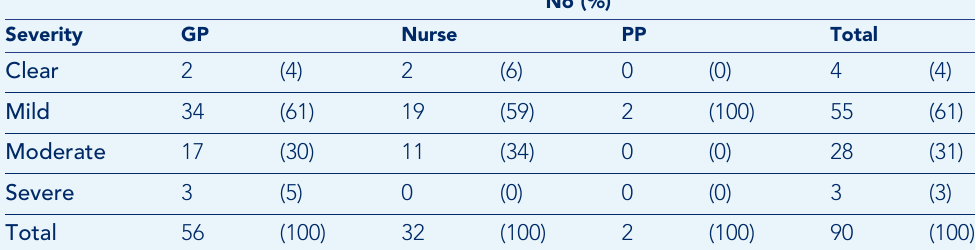
Table S1. Clinical assessment of eczema severity by healthcare professional